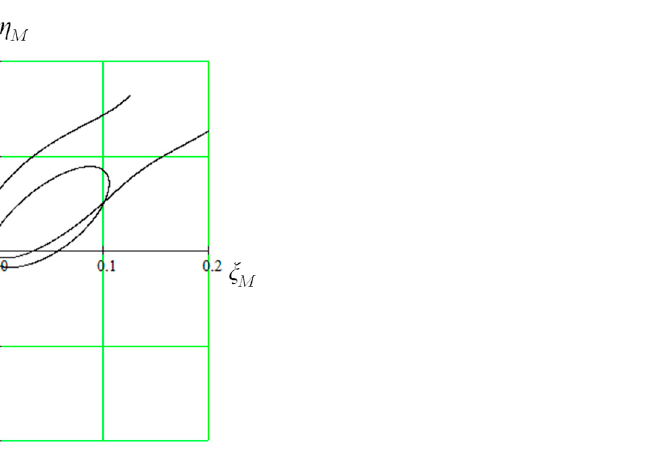
Figure 19. The trajectory of the spacecraft movement corresponding to the “circumlunar” segment (starting from time t 1 to 1